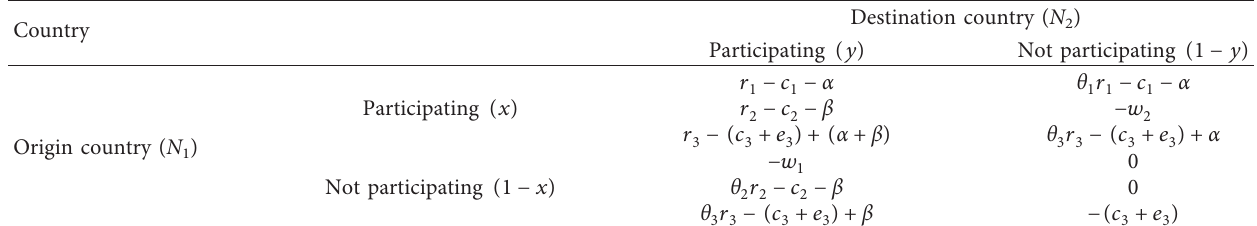
3 ) chooses “strong participation.”